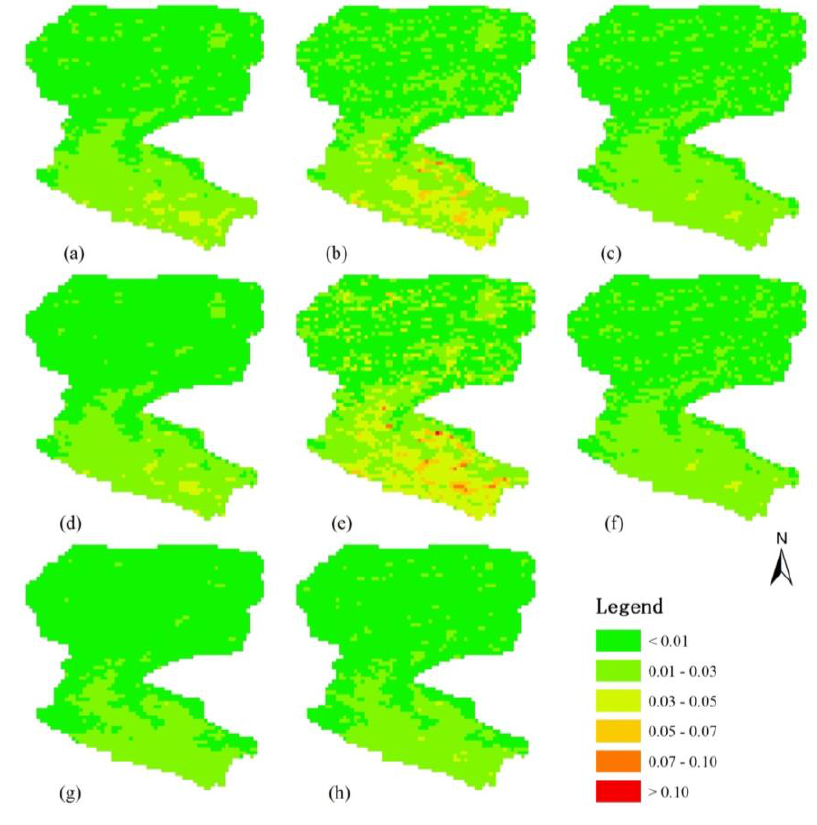
Figure 7. Root mean square error (RMSE) of the PAL NDVI for the eight techniques: ( a ) the asymmetric Gaussian (A-G) technique; ( b ) the modified-best index slope extraction (M-BISE) technique; ( c ) the changing-weight filter (CW) technique; ( d ) the double logistic function (D-L) technique; ( e ) the iterative interpolation for data reconstruction (IDR) technique; ( f ) the mean value iteration (MVI); ( g ) the Savitzky-Golay filter (S-G) technique, and ( h ) the Whittaker smoother (WS)